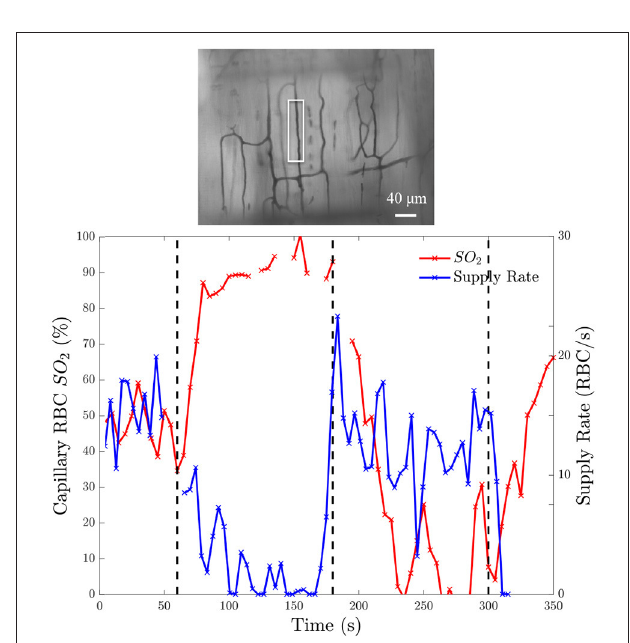
FIGURE 9 | Oxygen saturation and supply rate change in response to square wave oxygen challenge from a baseline of 5% O 2 followed by 2 min of 12%, 2 min of 2%, and 1 min of 5% with 5% CO 2 and balance N 2 . (Bottom) Induced SO 2 changes is given on the left ordinate axis and the corresponding change in RBC supply rate is given on the right ordinate axis. The black dashed lines indicate the time at which the chamber O 2 was changed. The analyzed capillary is indicated with a white box in the minimum intensity functional image above the figure (Top)